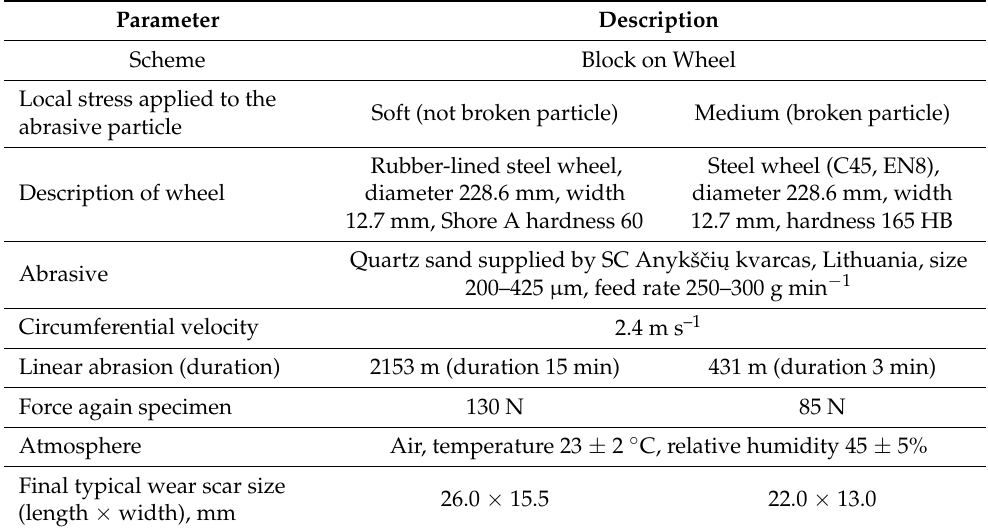
Figure 3. Schematic diagram of abrasive and erosive wear testers: ( A ) abrasive wear test with rubber-lined or steel wheel, ( B ) erosive wear test at room or high temperature. Table 2. Abrasive wear tests conditions.